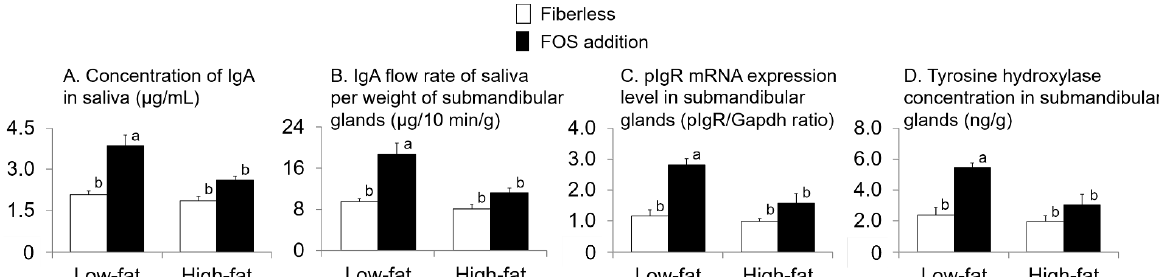
Figure 5. Effects of fat intake and fructo-oligosaccharide (FOS) supplementation on the concentra- tion of IgA ( A ) and immunoglobulin G (IgG) in serum ( B ). Values are Means ± SEM. n = 8 per group. two-way ANOVA. Values with different superscript letters are significantly different ( p <